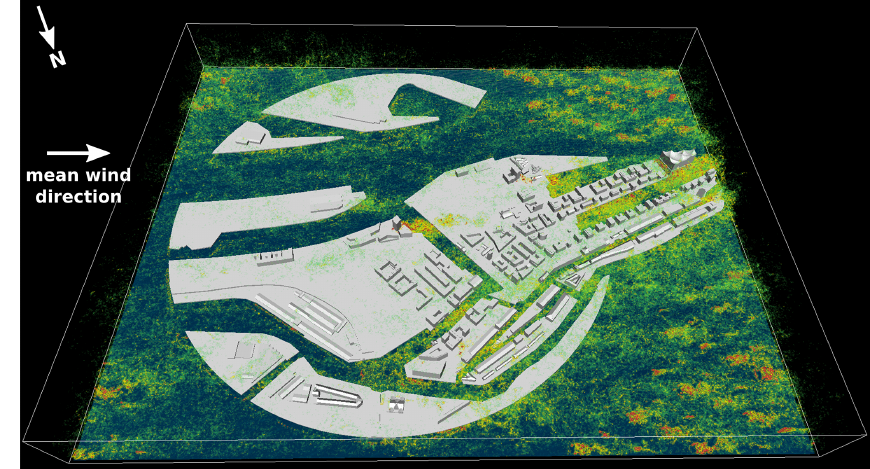
Figure 7. View of the volume-rendered instantaneous turbulence structures above the building array. Turbulence is visualized using the magnitude of the three-dimensional vorticity. Green and red indicate low and high values, respectively. The image was rendered using VAPOR (Li et al., 2019, http://www.vapor.ucar.edu/, last access: 2 June 2021) and the background image was designed by freepic.diller/Freepik (http://www.freepik.com, last access: 16 May